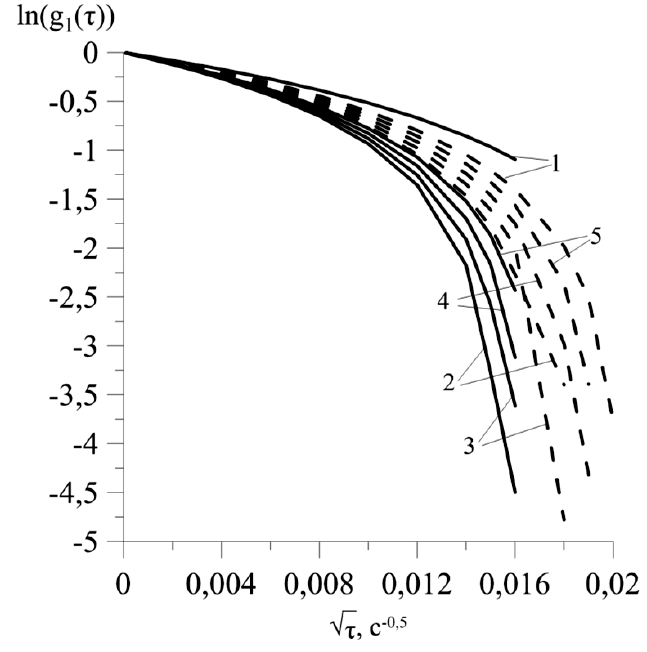
Figure 4. Typical autocorrelation functions g ( τ ) of field fluctuations under conditions of 1 different dynamics of blood flow in the experiment with compression of the brachial artery calculated in the MathCad system, 200 µm - solid curves , 100 µm - dashed curves 1 - before compression; 2 - after 1 min. 3 - after 2 minutes; 4 - in 3 minutes; 5 - after 4